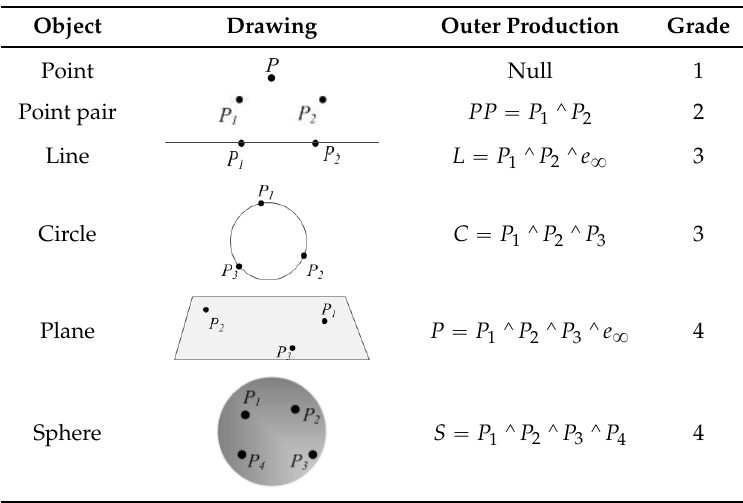
Table 1. Outer product expression of geometric objects in CGA.